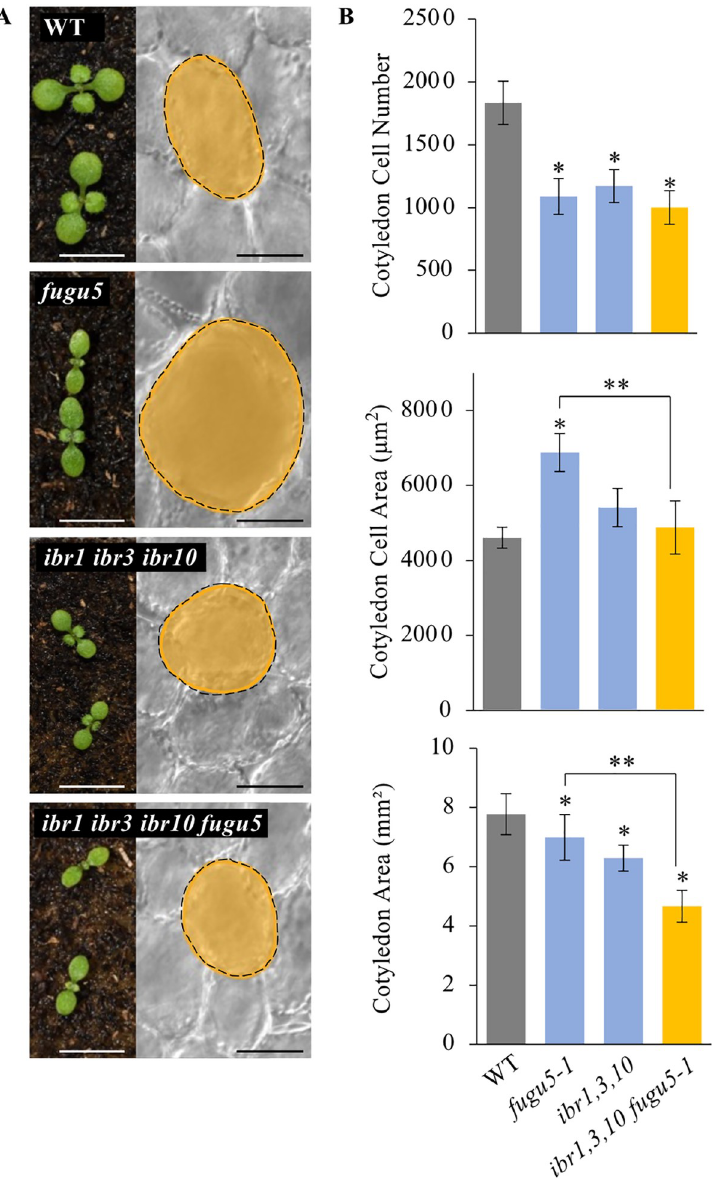
Fig 1. ibr Triple Mutation Suppressed Class II CCE in fugu5 Background. (A) Gross and cellular phenotypes. Photographs show the seedling gross morphology, taken at 10 DAS. White bars = 4 mm. Corresponding palisade tissue cells images taken at 25 DAS. Black bars = 50 μ m. (B) Quantification of cotyledon cellular phenotypes. Cotyledons of each genotype were dissected from plants grown on rockwool for 25 DAS, fixed in FAA, and cleared for microscopic observations. Data show cotyledon cell number, cell areas and cotyledon area. Data are means ± SD (n = 16 cotyledons). Single asterisk indicates that the mutant was statistically significantly different compared to the WT (Tukey’s HSD test at P < 0.05; R version 3.5.1), and double asterisk indicates that the quadruple mutant was statistically significantly different compared to fugu5–1 (Tukey’s HSD test at P < 0.05; R version 3.5.1) DAS, days after